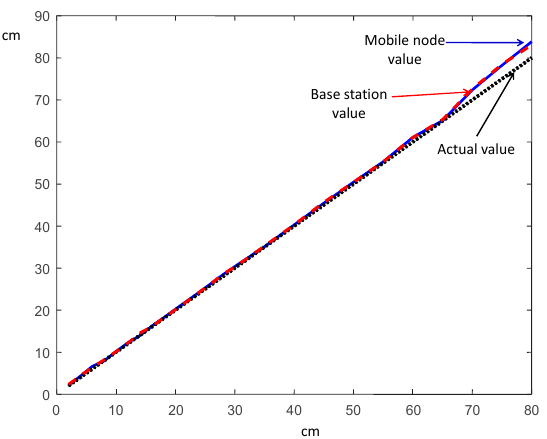
Figure 7. Measured versus real distance, at both the base and the remote stations.